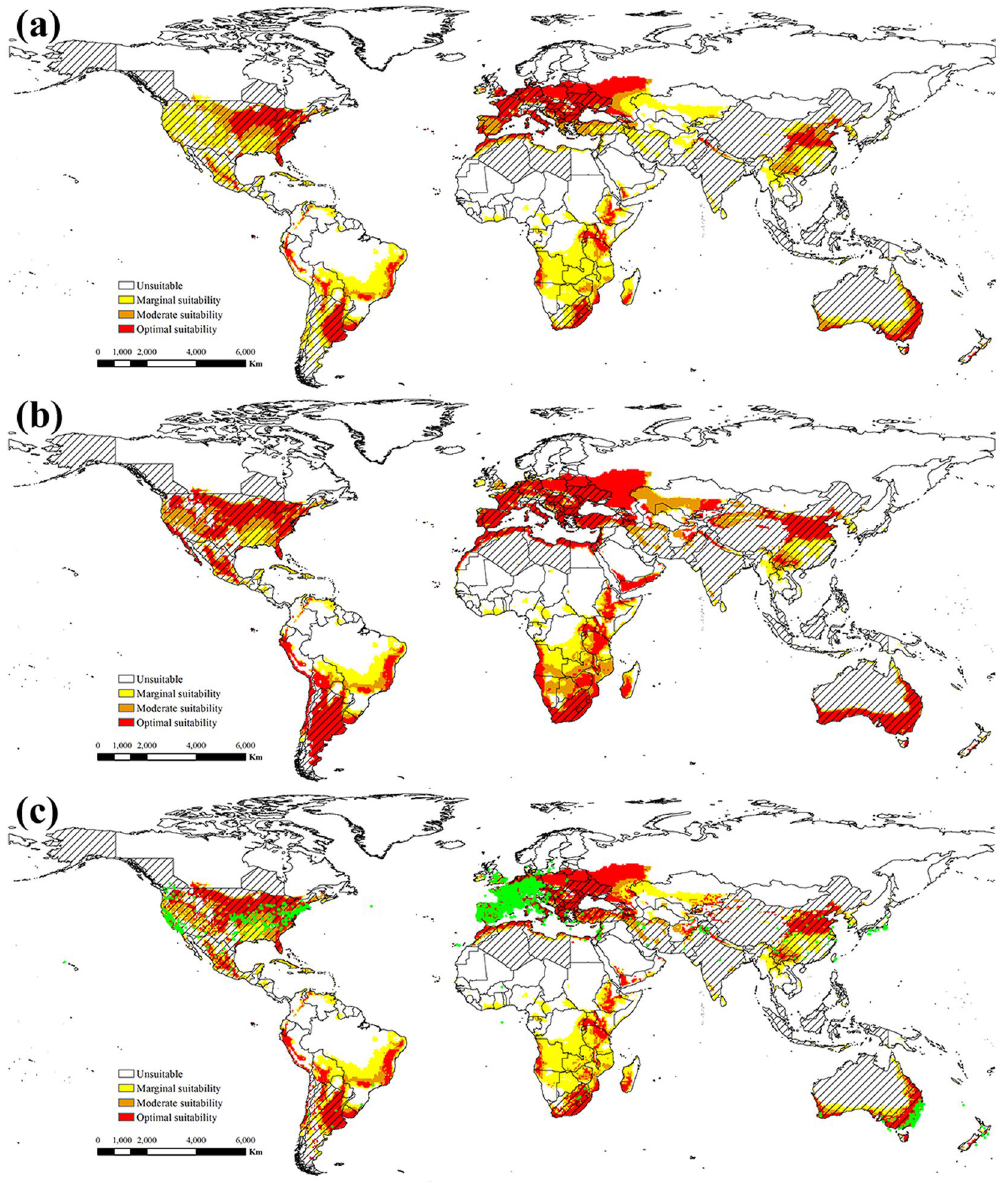
Figure 1. The projected global climate suitability for ESC under the historical climate, ( a ) without irrigation, ( b ) with 2.5 mm in the summer and 1.5 mm in the winter top-up irrigation and ( c ) with a composite risk irrigation scenario (where areas are not under irrigation, the EI of the natural rainfall scenario is mapped, while with areas under irrigation the EI of the irrigation scenario is mapped), using the CLIMEX EI. Slash indicate the distribution countries of tree-of-heaven. Green points indicate the distribution locations of tree-of-heaven. Yellow indicates areas of marginal suitability (0 < EI ≤ 10); Orange indicates areas of moderate suitability (10 < EI ≤ 20); Red indicates areas of optimal suitability (EI ≥ 20). The map in this figure was generated by ArcGIS 10.1 (ESRI, Redlands, CA, USA,